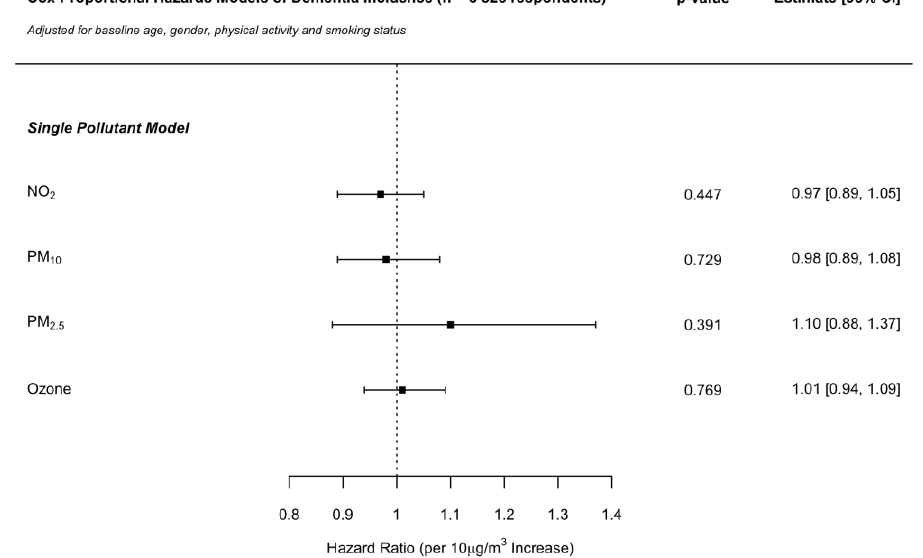
Figure 1. Cox proportional hazards model hazard ratios per 10 µ g/m 3 increase in NO 2 , PM 10 , PM 2.5 and ozone concentrations on dementia incidence in the ELSA cohort across England. Independent single pollutant models adjusted for baseline age, gender, physical activity and smoking status.